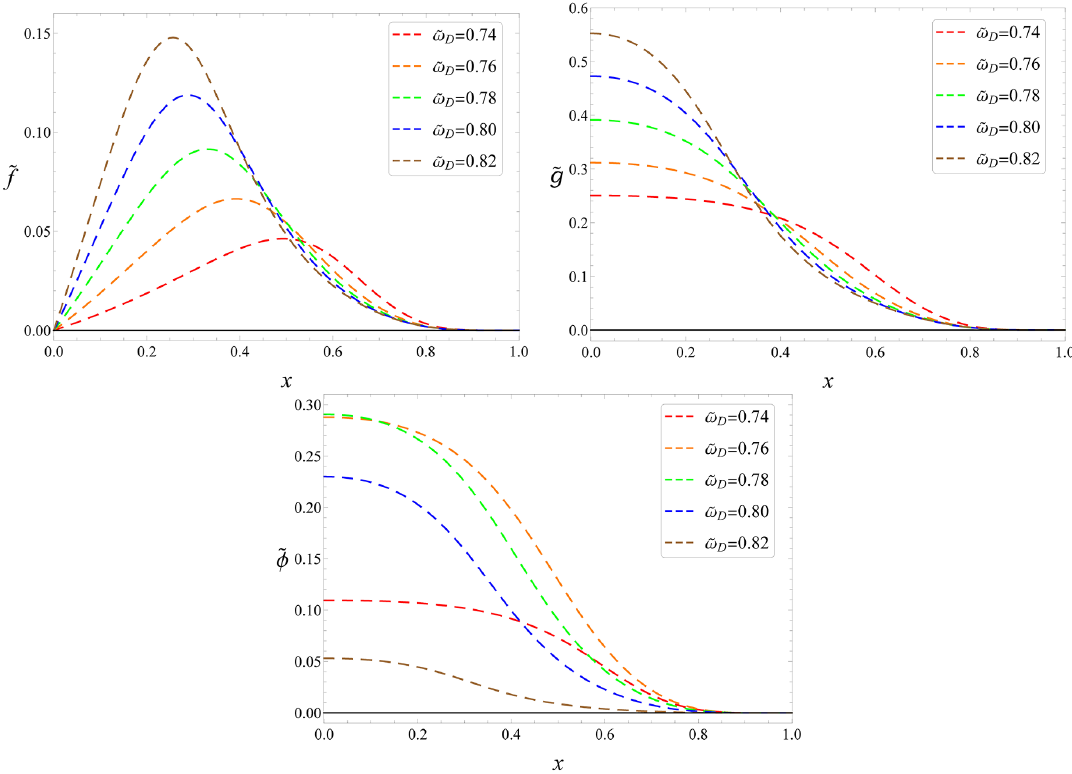
Figure 9. Dirac field functions ˜ f and ˜ g (top panels) and Scalar field function ˜ φ (bottom panel) as functions of x with ˜ ω D = 0 . 74 , 0 . 76 , 0 . 78 , 0 . 80 , 0 . 82 . All solutions have ˜ ω S = 0 . 702 and ˜ µ S = ˜ µ D = 1